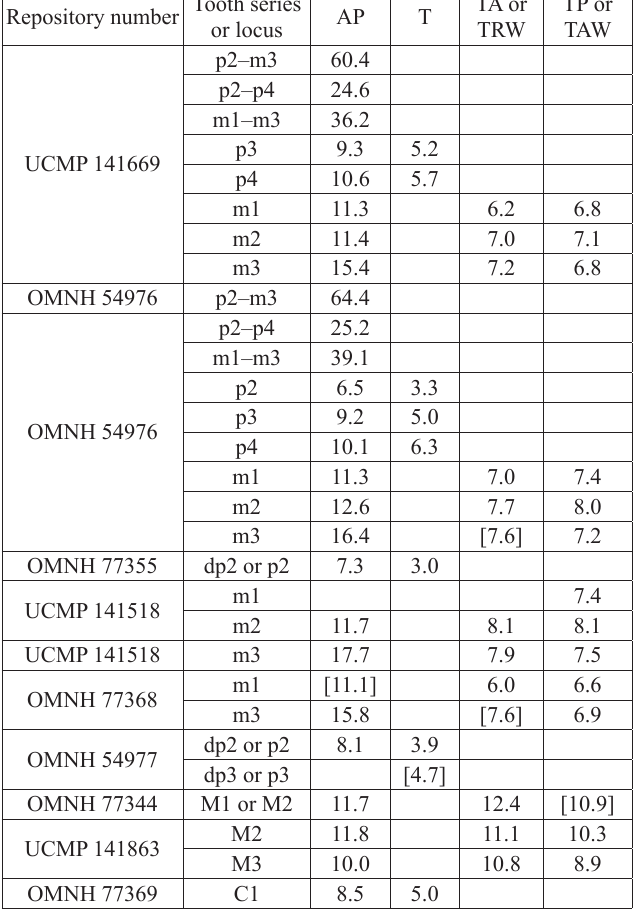
Table 2. Measurements (in mm) of Barbouromeryx trigonocorneus teeth from the Eastgate fauna. Brackets indicate estimated measure- ment of a broken specimen. Abbreviations: AP, greatest anteroposterior length of tooth; T, greatest transverse width of tooth; TA, greatest trans- verse width of anterior half of tooth; TAW, greatest width of talonid part of tooth; TP, greatest transverse width of posterior half of tooth; TRW, greatest width of trigonid part of tooth.